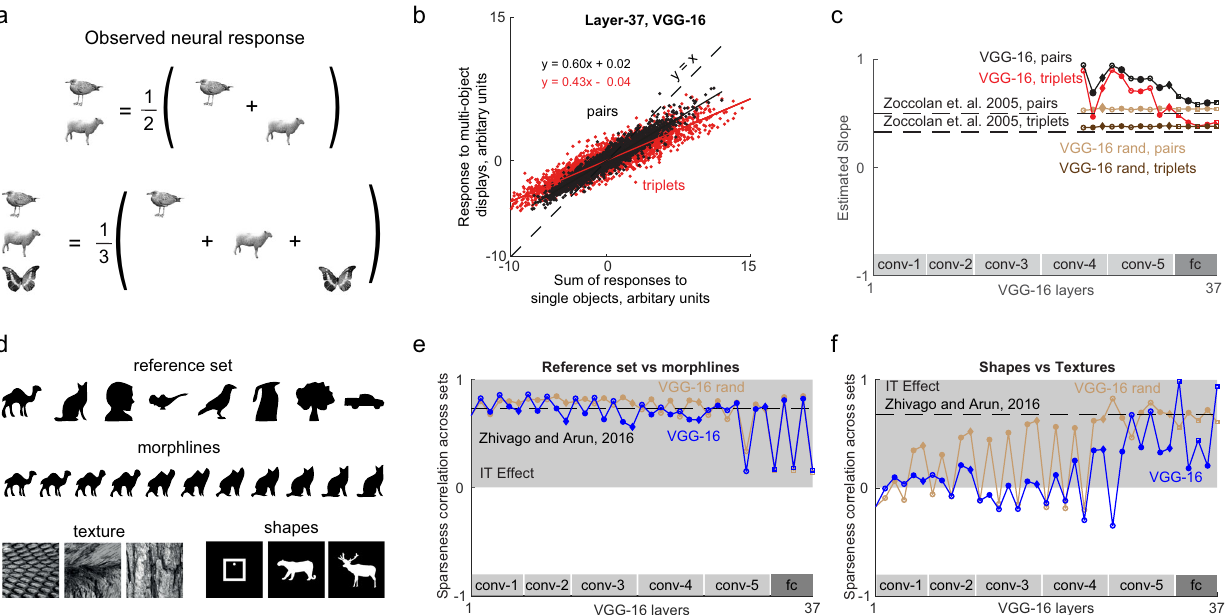
Fig. 3 Single unit properties of deep networks. a Schematic illustrating the general principle observed in neurons in high-level visual areas of the brain. The response of a neuron to multiple objects is typically the average of its responses to the individual objects at those locations. b Response to multiple- object displays plotted against the sum of the individual object responses for two-object displays (black) and three-object displays (red), across 10,000 units randomly selected from Layer 37 of the VGG-16 network. c Normalization slope plotted across layers for two object displays ( blue ) and three-object displays ( brown ) for the VGG-16 network and a randomly initialized VGG-16 ( brown ). The dashed lines depict the slopes observed in monkey IT neurons using a different stimulus set 21 . d Selected stimuli used to compare sparseness across multiple dimensions in a previous study of IT neurons 22 . e Correlation between sparseness on the reference set vs. along morphlines across units of each layer in the VGG-16 network ( blue ) and a VGG-16 with random weights ( brown ). The dashed line indicates the observed correlation in monkey IT neurons on the same set of stimuli. f Correlation between sparseness for textures and sparseness for shapes plotted across layers of the VGG-16 network ( blue ) and a VGG-16 with random weights ( brown ). The dashed line indicates the observed correlation in monkey IT neurons on the same set of